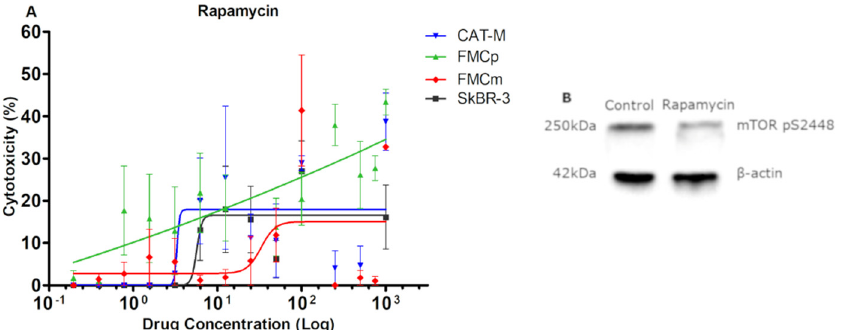
decrease in the phosphorylation levels of mTOR at S2448. ( A ) The most susceptible cell line to rapamycin exposure was FMCp (43.4% of cytotoxicity) followed by the FMCm (41.3% of cytotoxicity) and the CAT-M cell lines (38.7% of cytotoxicity). The human SkBR-3 cell line was used